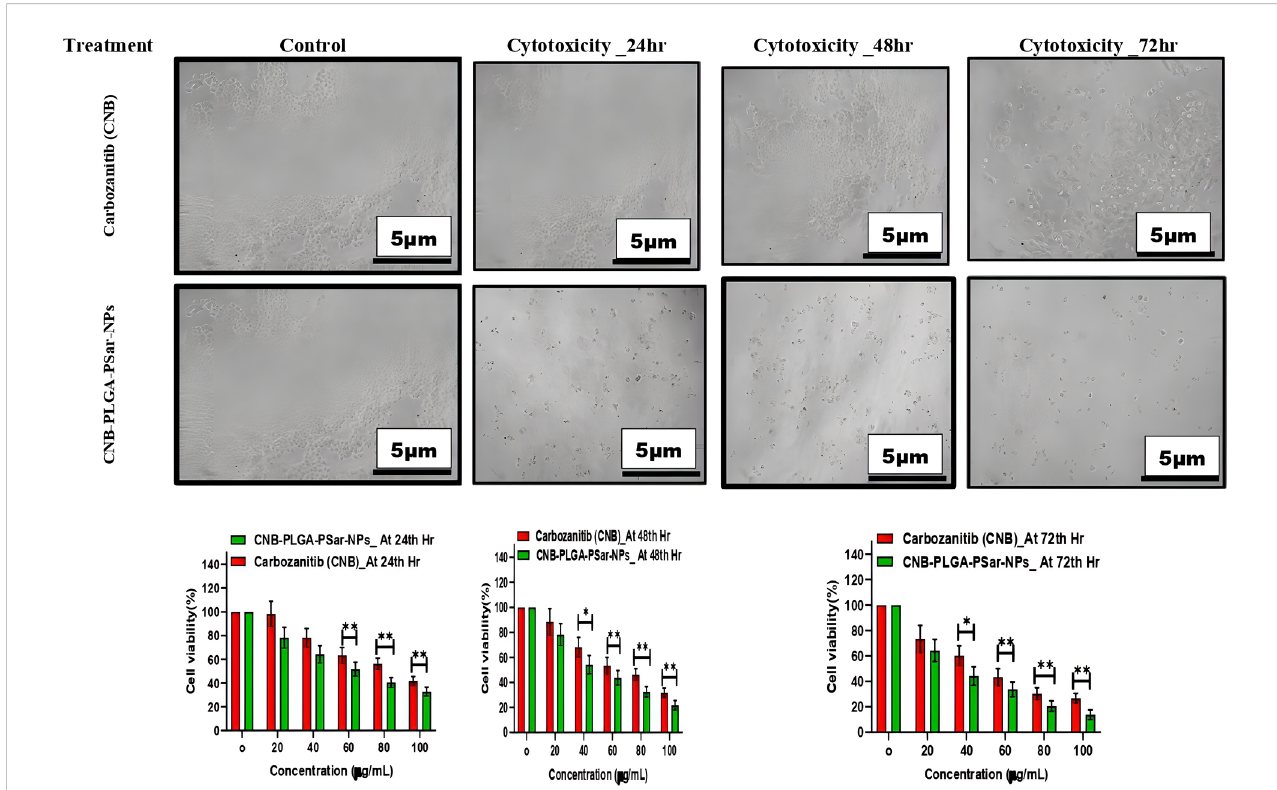
FIGURE 3 EffectofdifferentconcentrationsofCNB-loadedCNB-PLGA-PSar-NPsandfreeCNBontheviabilityofhepatocellularcarcinomacellline(HepG2)cellsafter24,48, and72hincubation.The fi gureshowsthatCNB-loadedCNB-PLGA-PSar-NPsaremoreanti-proliferativewhencomparedwithCNB(*p<0.05).Thecellviability